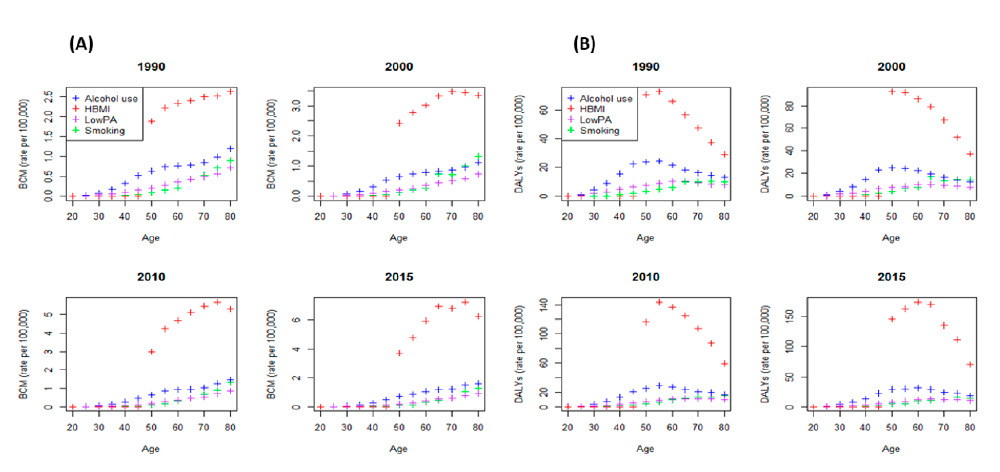
Figure 1. Trends in breast cancer mortality (BCM) and disability-adjusted life years (DALYs) across ages within di ff erent risk factors (high body mass index (HBMI), alcohol use, low physical activity (PA), and smoking) in years 1990, 2000, 2010, and 2015. ( A ) The left panel indicate the BCM plots, and ( B ) the right panel indicate the breast cancer DALYs plots.